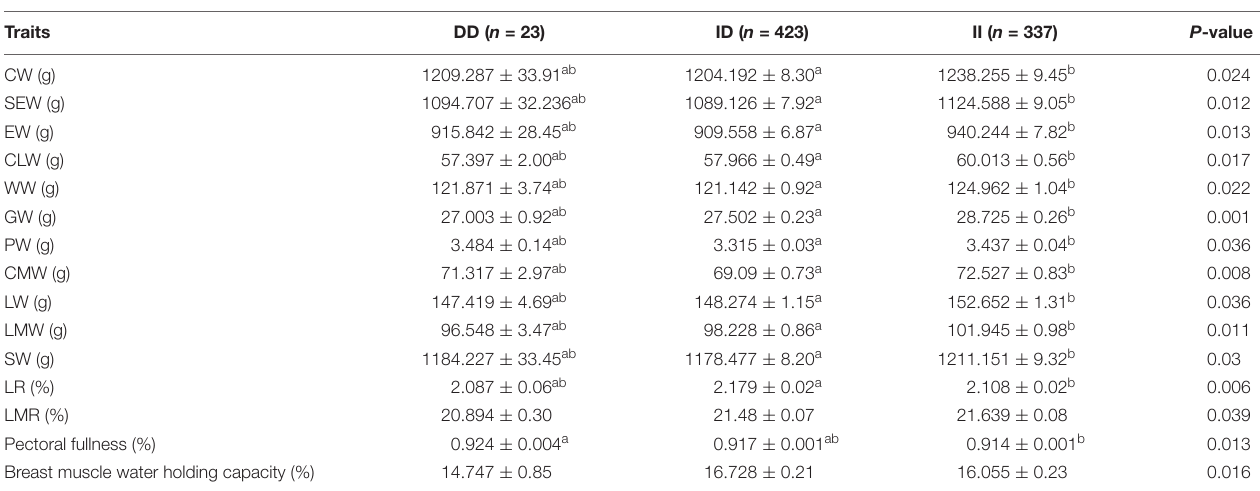
TABLE 4 | Association of the 104-bp locus with carcass traits in an F 2 population at 84 days of age.